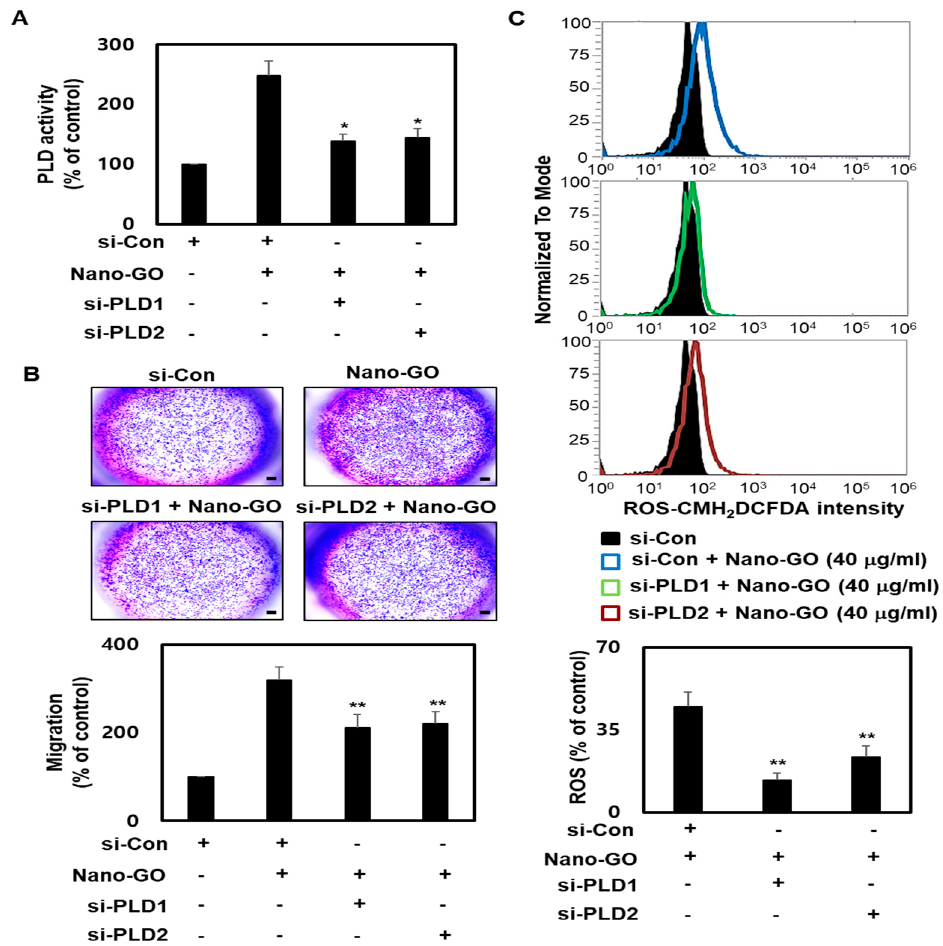
Figure 6. Effect of Nano-GO on RPE cell migration and ROS production through the PLD signal. RPE cells were treated with si-Control, si-PLD1, or si-PLD2, and then treated with Nano-GO (40 µ g/mL) for 24 h. ( A ) PLD enzymatic activity was assessed using the Amplex Red Phospholipase D Assay Kit ( B ) RPE cell migration was assessed via cell migration assay (scale bar; 50 μ m). ( C ) Intracellular ROS production was assessed via CM-H 2 DCFDA using flow cytometry. All data are presented as the mean ± SEM ( n = 3). * p < 0.05 and ** p < 0.01 compared to the Control.